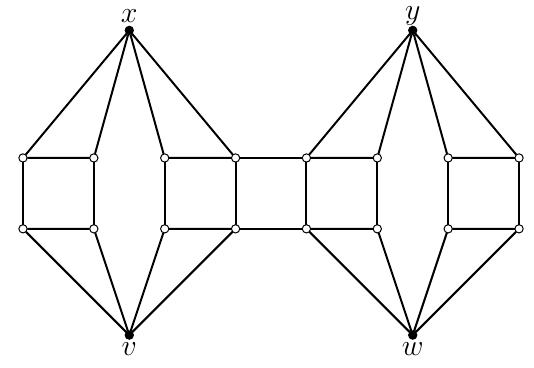
Figure 3: A graph G of order 20 with γ